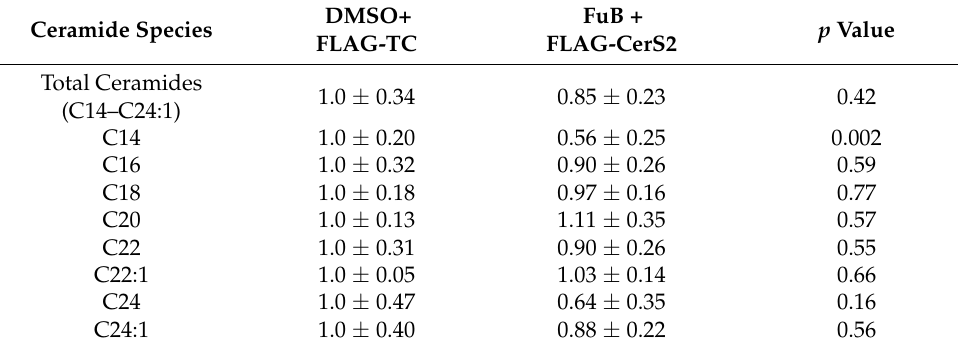
Table 6. ceramide levels in FuB pre-treated and transfected